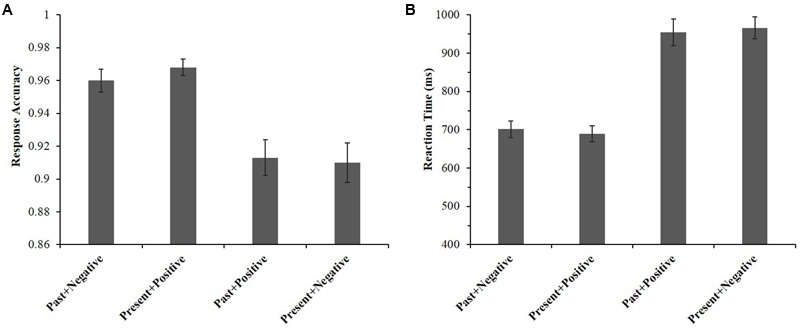
Comparisons of response accuracies (A) and reaction times (B) among four associations during the IAT.